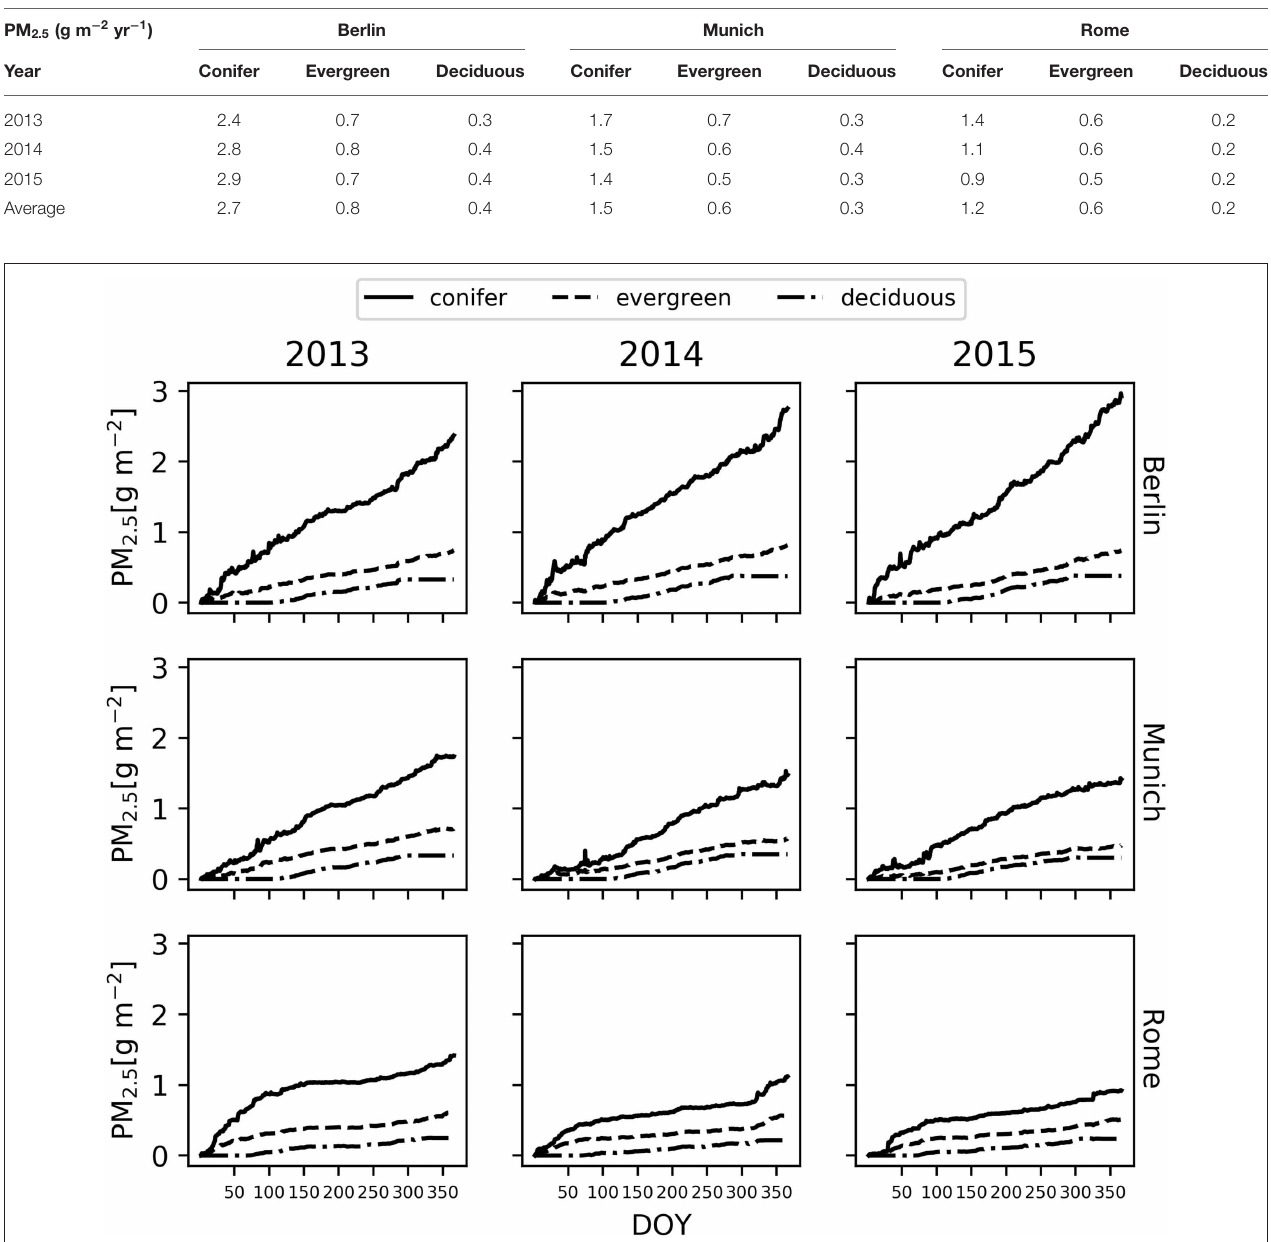
TABLE 6 | Annual PM 2.5 removal by different tree types in three cities.